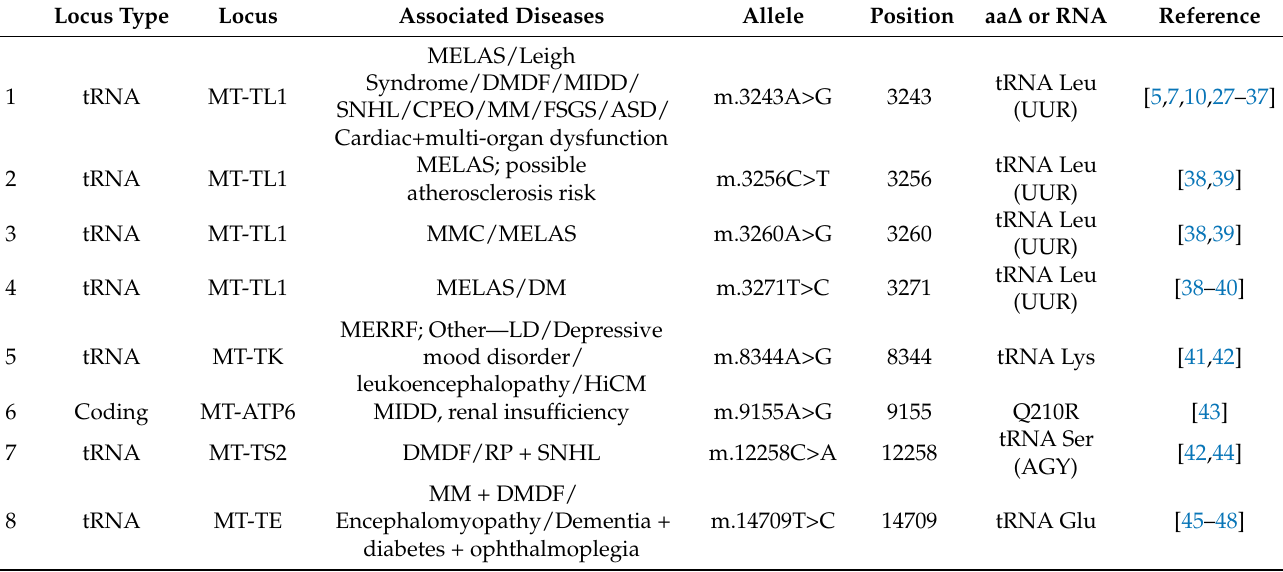
Table 1. Point mutations of mitochondrial DNA associated with